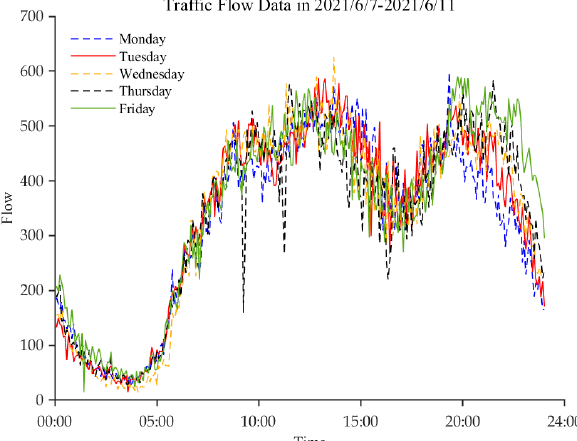
Figure 5. Traffic flow map.